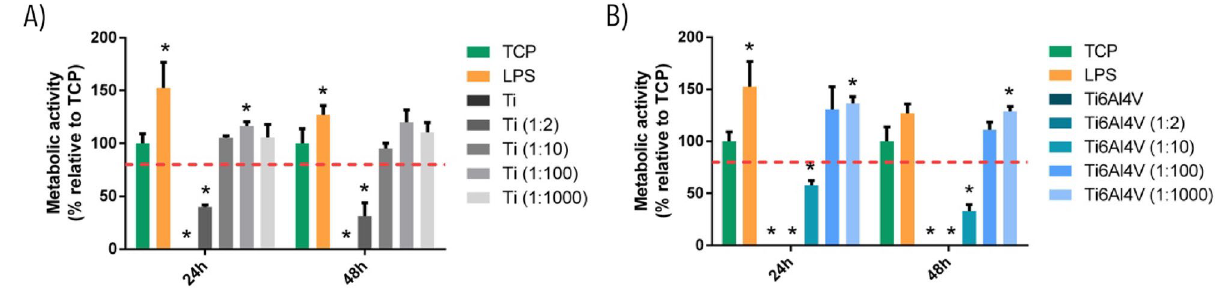
Figure 1. Effect of Ti ( A ) and Ti6Al4V ( B ) particles upon THP-1 cell metabolic activity after 24 h and 48 h culture. Metabolic activity results were represented as percentage relative to an unstimulated control (TCP) and compared with the TCP of each day. Values < 80% metabolic activity (red line) which were significantly different ( p < 0.05) from TCP were considered cytotoxic. Statistically significant differences ( p < 0.05) are represented with